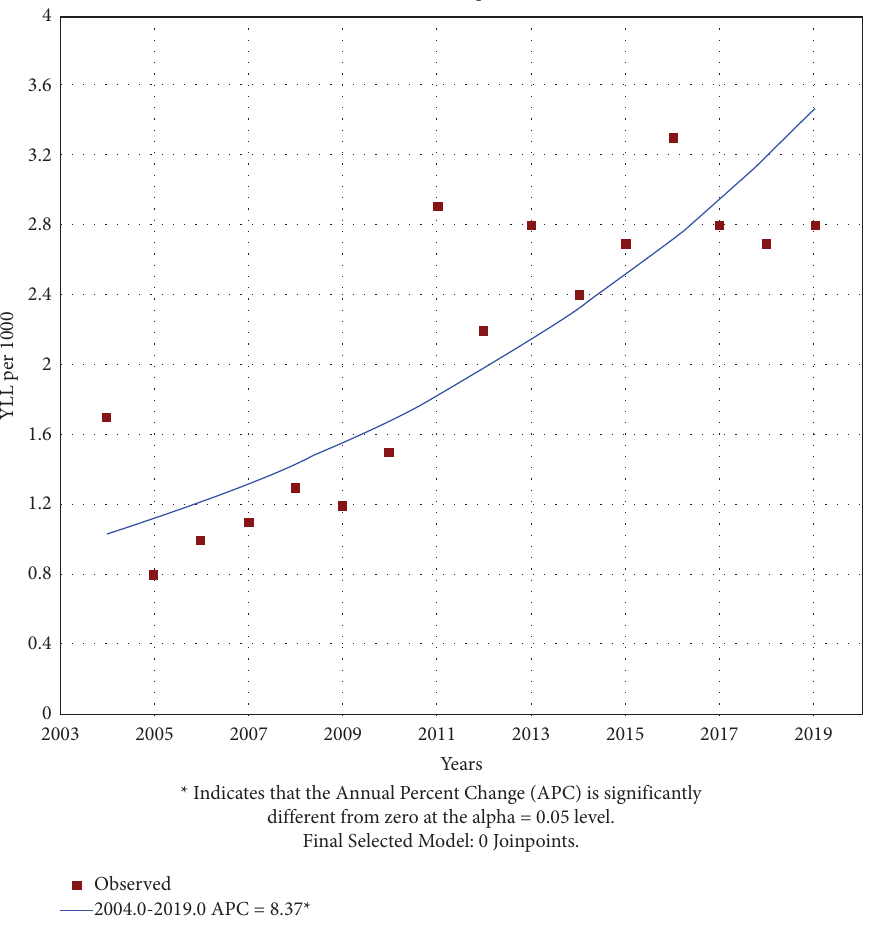
Figure 4: Trend of YLL rate to hypertension in females